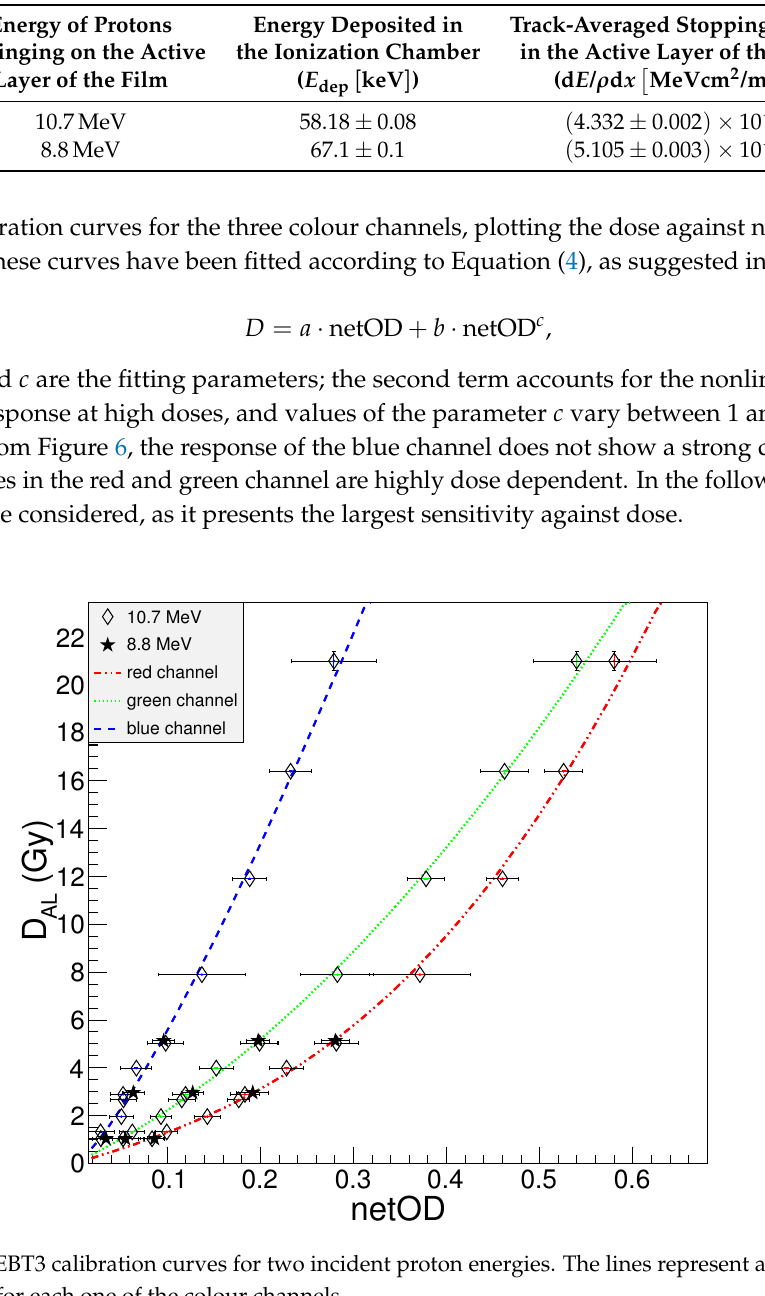
Table 2. Mean values and associated errors obtained from a Gaussian fit of the distributions shown in Figure 5. Energy refers to the mean energy impinging on the active layer of the film, after degradation in tungsten foils and air. E dep and d E / ρ d x are, respectively, the mean energy deposited in the ionization chamber and the mean value of the track-averaged stopping power in the active layer of the film.